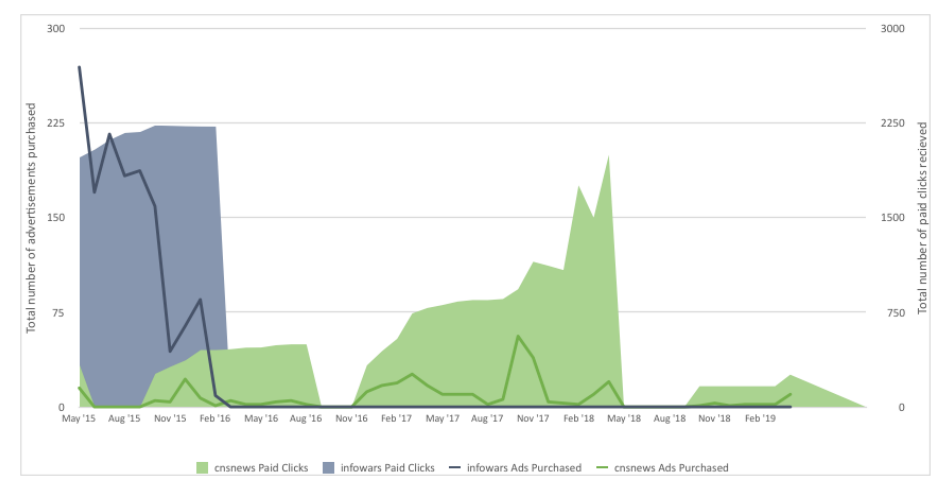
Figure 1: Advertisements purchased vs. paid clicks received: inforwars.com and cnsnews.com (May